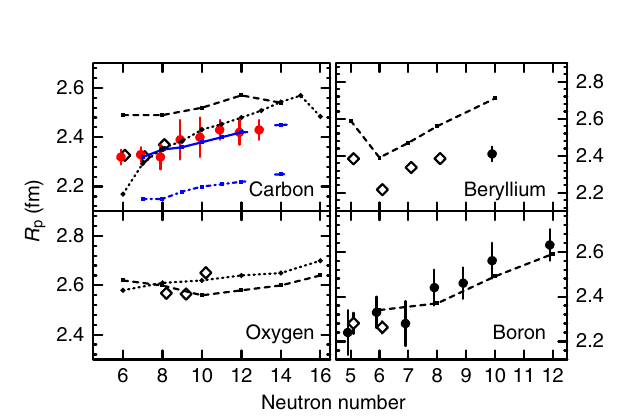
Fig. 2 Proton radii. Results are shown for carbon, beryllium, boron and oxygen isotopes. The red- fi lled and black- fi lled circles are, respectively, the proton radii from this and our recent work 32 – 34,37 . The open diamonds are the data from electron-scattering and isotope-shift methods 12 . The error bars for the red- fi lled circles include the statistical and experimental systematic uncertainties, as well as the uncertainties due to the choice of density distributions. The error bars for other experimental data are taken from the literature. The small symbols connected with dashed and dotted lines are the predictions from the AMD 19 and RMF 38 models, respectively. The small blue symbols with solid and dash-dotted lines are the results from the ab initio coupled-cluster calculations with NNLO sat 39 and the NN- only interaction NNLO opt